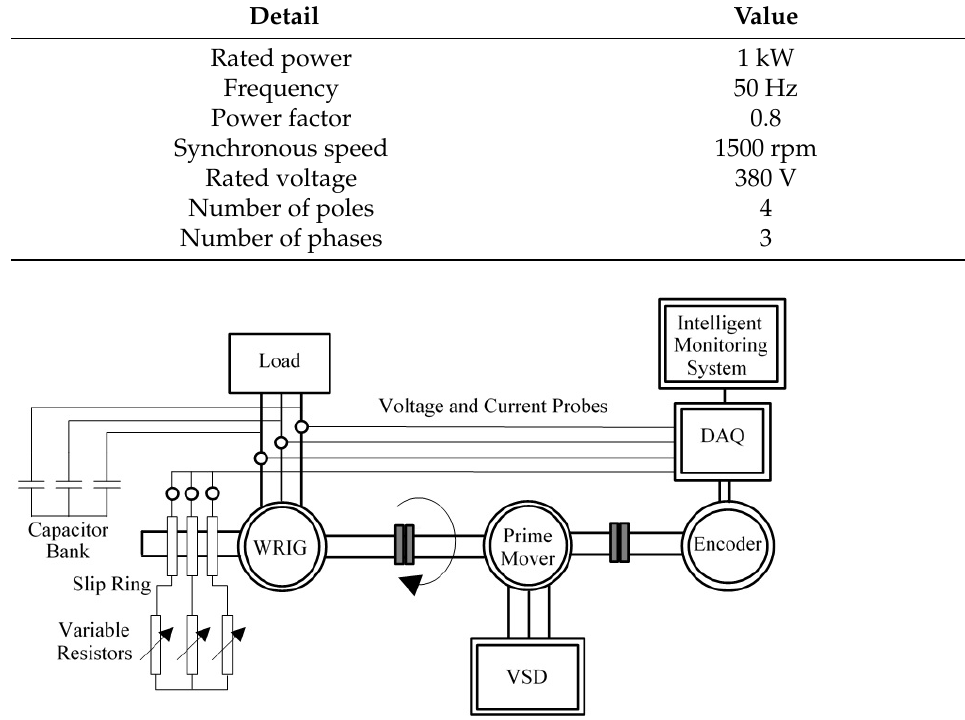
Table 3. Nameplate details of experimental induction machine.